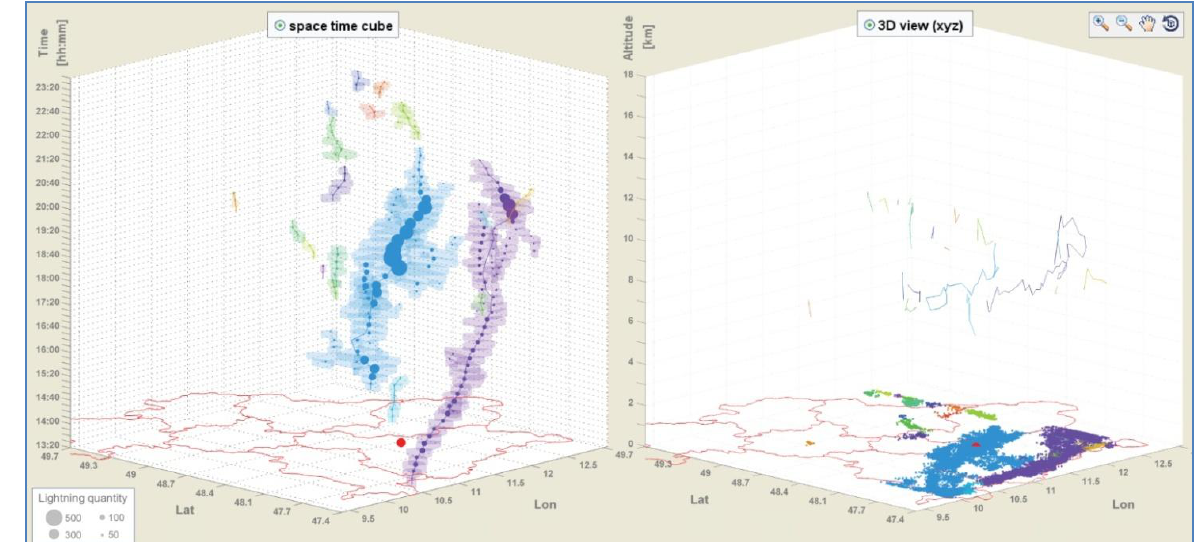
Figure 6. STC of lightning tracks ( Left ), 3D view of lightning tracks ( Right